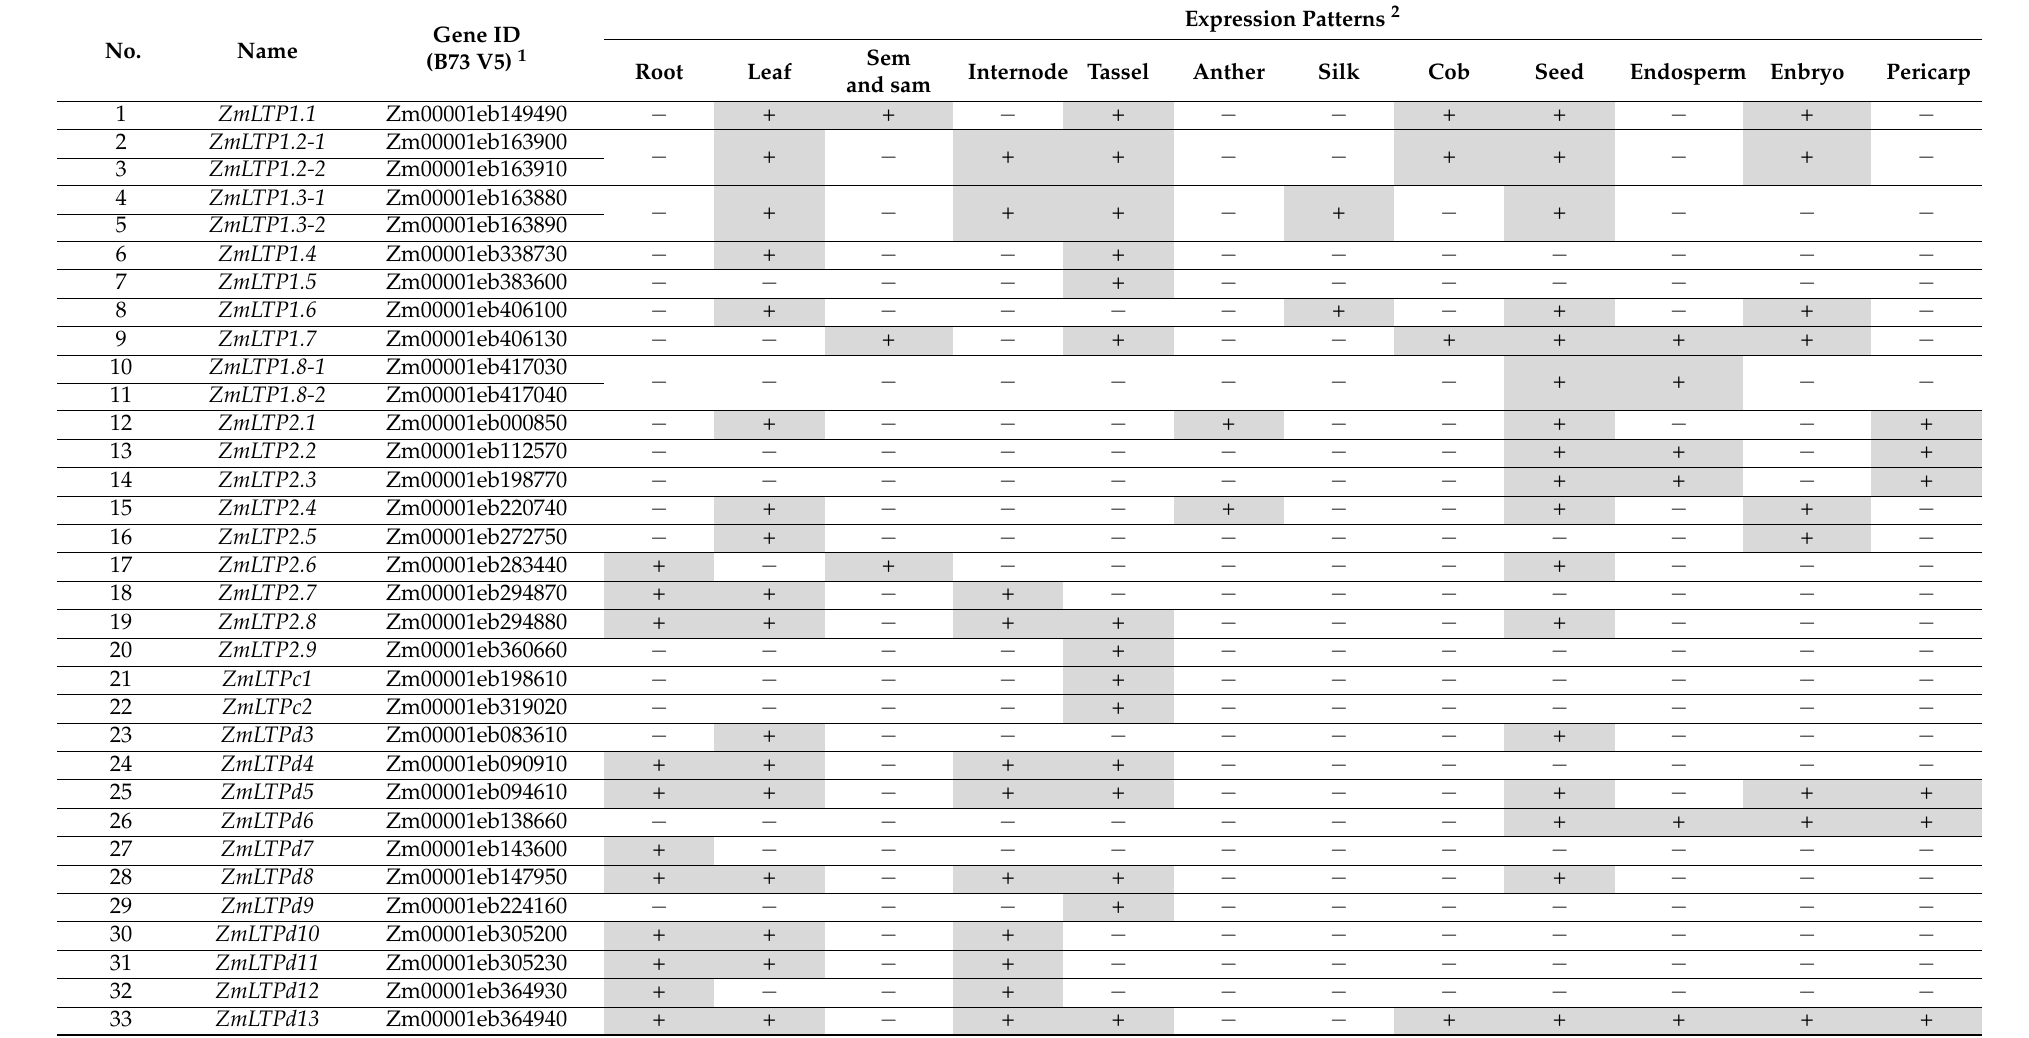
Table 1. The maize LTP family: LTP genes based on B73 reference genome V5.0 and expression